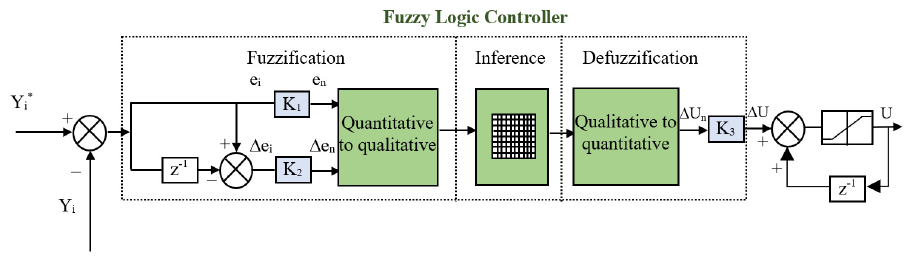
Figure 2. Fuzzy Proportional Integral control system.